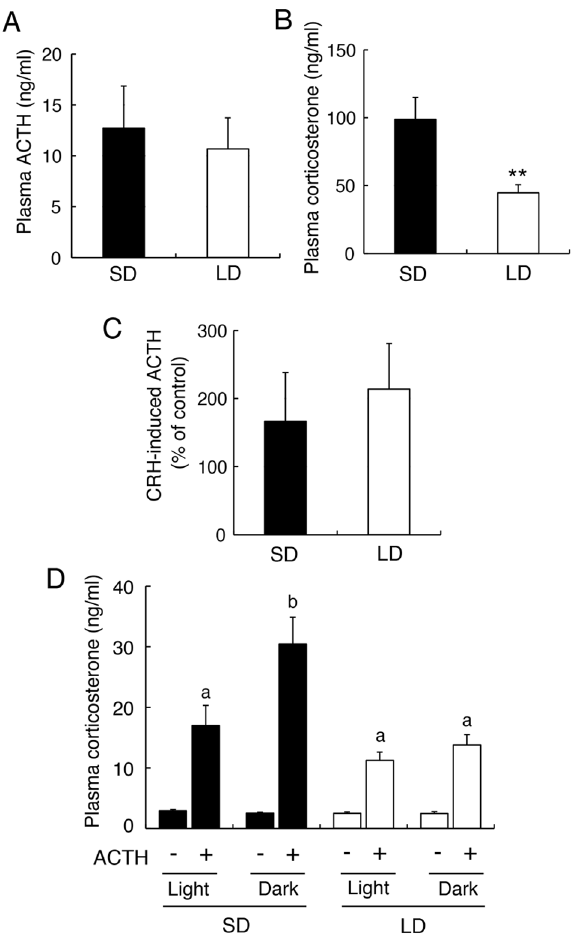
Figure 3. Effects of photoperiod on the HPA axis in Fischer 344 rats. Rats were maintained under either short-day condition (SD, 8 h of light, 16 h of darkness, black bars ) or long-day condition (LD, 16 h of light, 8 h of darkness, white bars ) for 2 weeks, and examined plasma concentrations of ACTH (A) and corticosterone (B) around Zeitgeber time 7–10 (ZT: ZT0 corresponds to the light onset). Corticosterone levels of rats under LD were significantly lower than those under SD (**, P , 0.01, t -test). (C) CRH-induced ACTH secretion from the organ culture of hemi-pars distalis dissected from animals exposed to either SD or LD. The data are indicated as the percentage of the CRH-induced ACTH level to the control level for each rat (n=4–6). (D) ACTH-induced corticosterone levels in dexamethasone-treated rats maintained under SD and LD. Rats were intraperitoneally injected with dexamethasone- 21-phosphate (0.97 m mol/kg body weight) 2 h prior to light onset (Light) or dark onset (Dark) under SD and LD, followed by in- traperitoneal injections of rat ACTH 1–24 (0.27 nmol/kg body weight) or saline 3 h after dexamethasone injections. Plasma samples were collected 20 min after ACTH injections. Different characters indicate significant differences within ACTH-injected groups ( P , 0.05, two-way ANOVA followed by Bonferroni’s multiple comparison test). Values are means + SEM (n=3–7). induced levels at dark onset were significantly higher than those at light onset ( P , 0.05), whereas no time differences were detected in rats exposed to long-day condition ( P . 0.05) (Figure 3D).